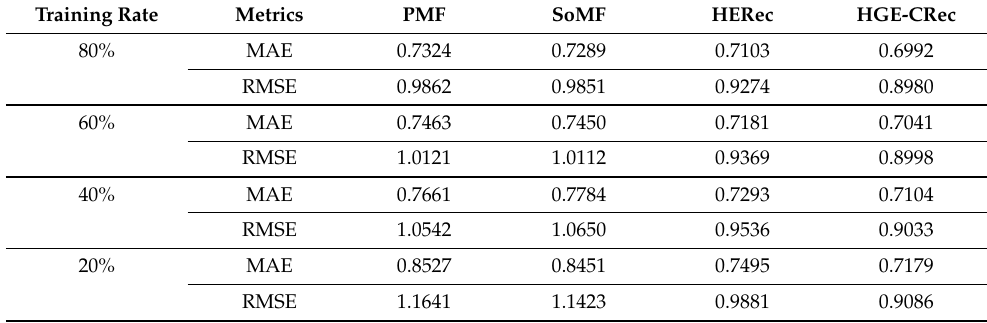
Table 7. Results on